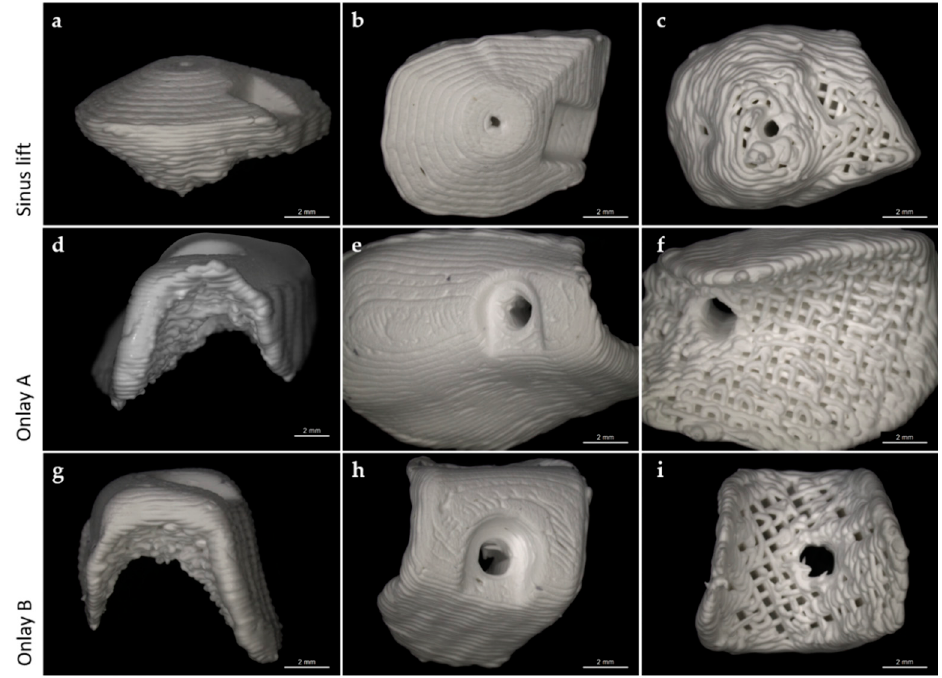
Figure 9. Individual scaffold for sinus floor elevation ( a – c ) and two onlay grafts in the lower jaw (region 36, 46: ( d – f ); region 47: ( g – i )).